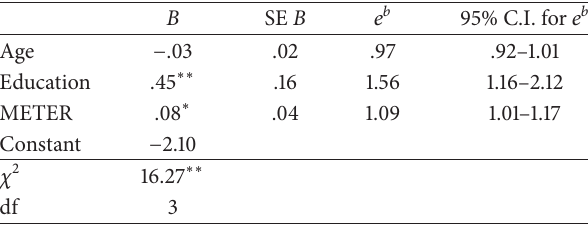
Table 5: Logistic regression analysis predicting e-mail use from age, education, and health literacy (METER).